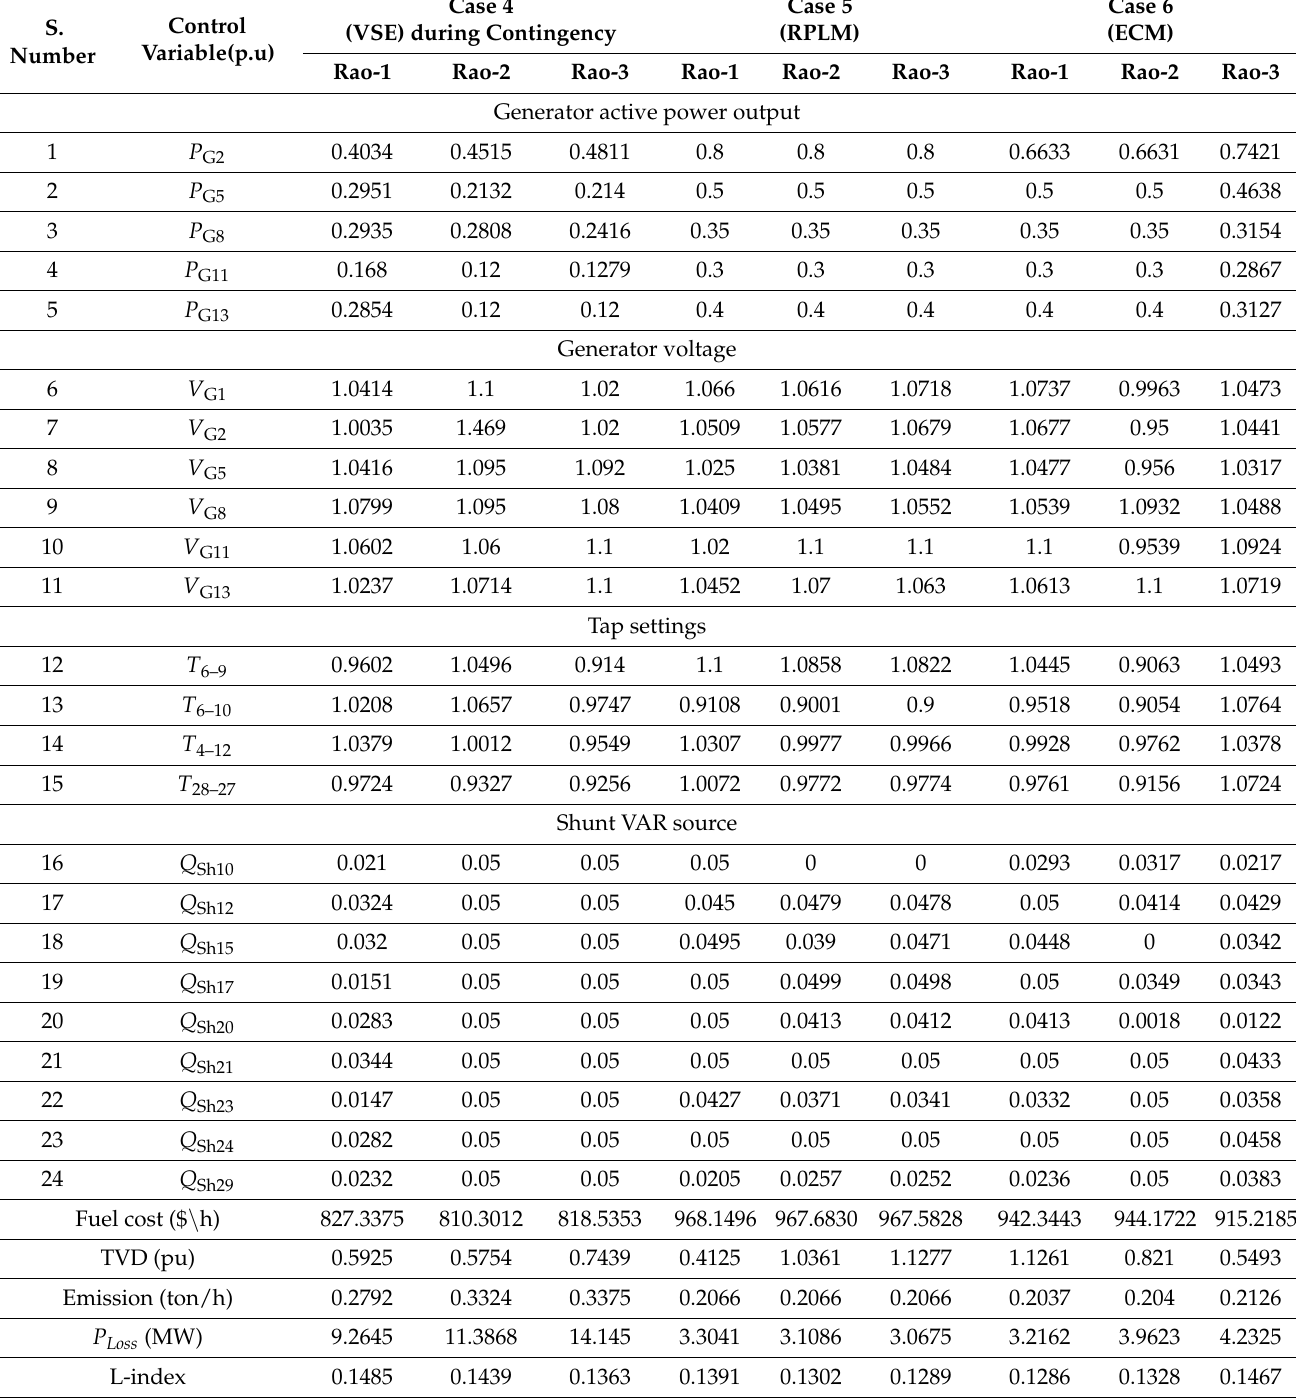
Table 7. Optimum values of control variables of Case 4, Case 5, and Case 6 of the IEEE 30-bus system.